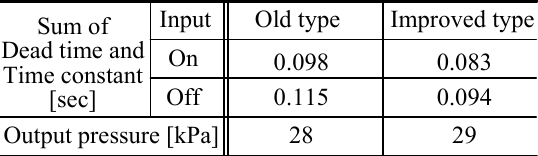
Comparison with old